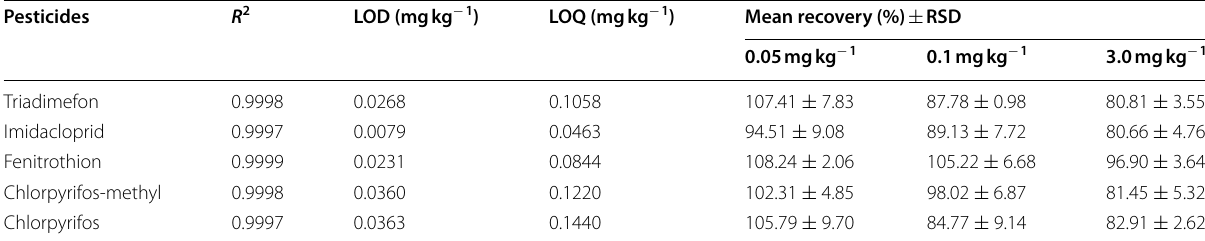
RSDs ( n 5) for five pesticides in wheat flour ± =